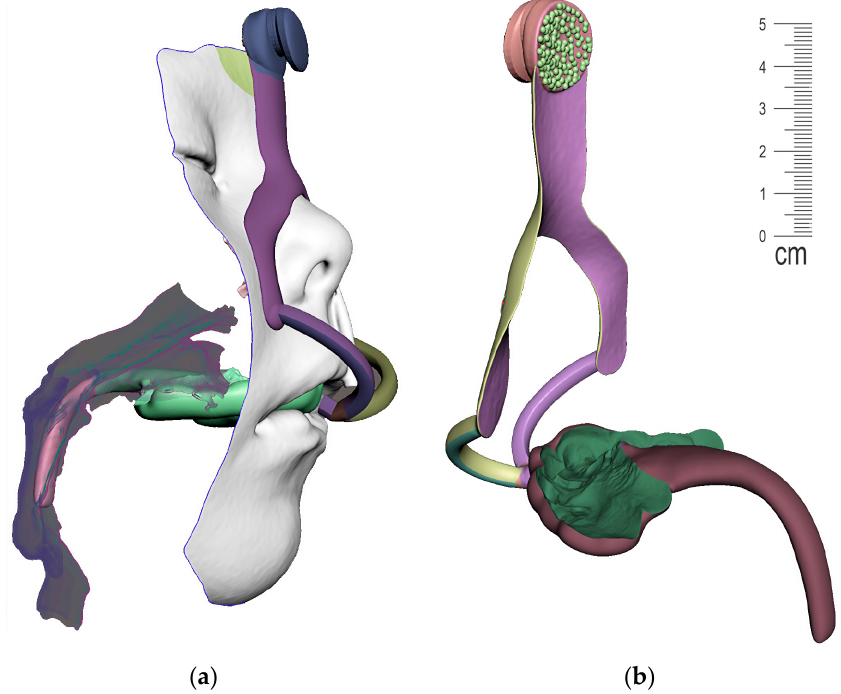
Figure 20. View of the final appearance of the appliance: ( a ) with patient; ( b ) without patient.